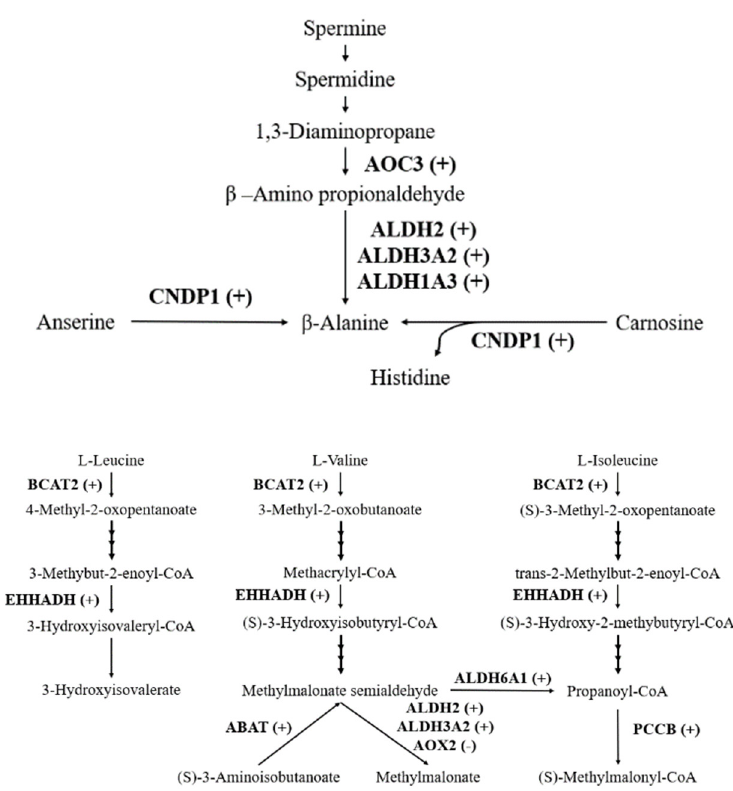
Figure 5. Amino acid metabolism-related DEPs. Compared with CON groups, ( + ) upregulated, (-) downregulated. Table 3. Results of metabolic enzyme activity